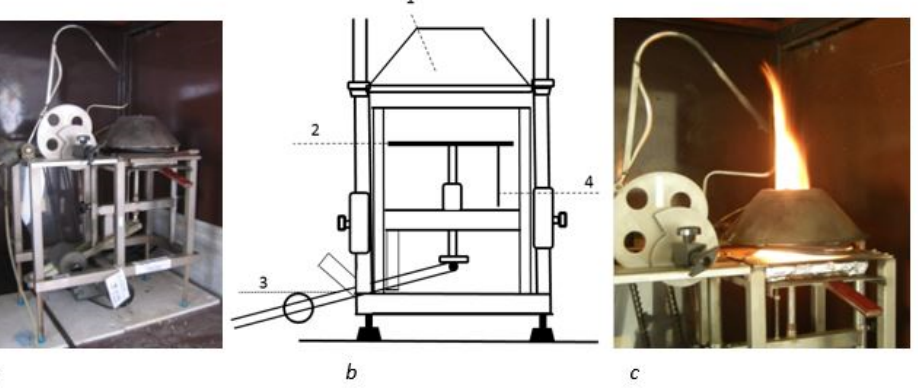
Figure 2. Scheme of the equipment for determination of flammability of materials at radiant heat flux of 10–50 kW.m − 2 according to ISO 5657: 1997 [65]. ( a ) Real test equipment and equipment scheme. ( b ) Scheme of the used equipment with description of components: 1—heating cone, 2—board for sample, 3—movable arm, 4—connection point for recording experimental data. ( c ) Detailed look at the burning of the particleboard sample with 18 mm thickness in 100 s.